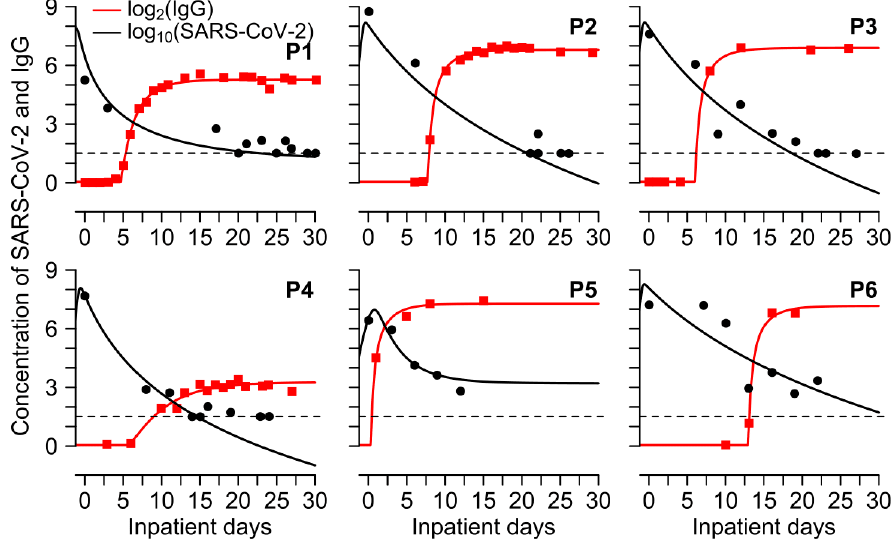
Figure 4. The mathematical model fits viral load and antibody levels following SARS-CoV-2 infection. Simulations (lines) to observed SARS-CoV-2 (black markers) and IgG (red markers) under the best model (MP-v2 in Table S3).